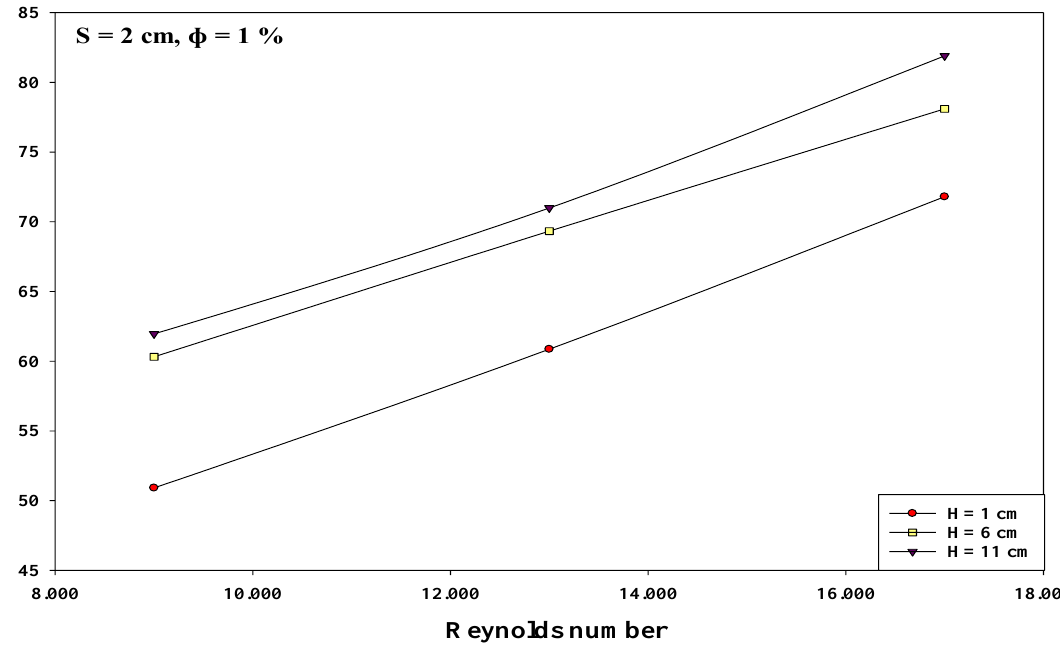
Figure 8. Effect of the Reynolds number and nozzle – plate distance when the nozzle – nozzle distance was 2 cm and other factors were maintained at their optimal levels.